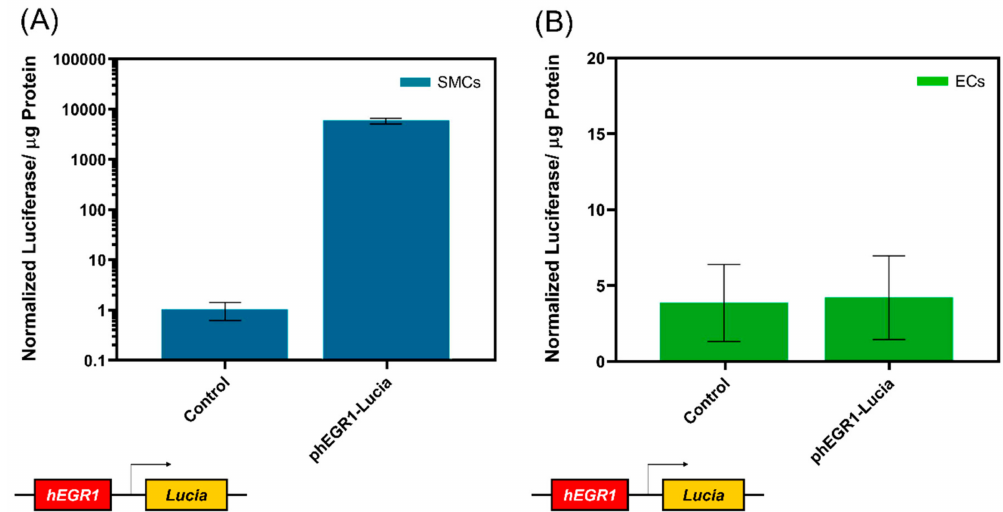
Figure 1. hEGR1 promoter activities in ( A ) smooth muscle cells (SMCs) and ( B ) endothelial cells (ECs) were characterized using the Lucia gene as a report gene. phEGR1-Lucia was transfected by E ff ectene ® Transfection Reagent, a commercial gene vehicle, to eliminate the noise factors from